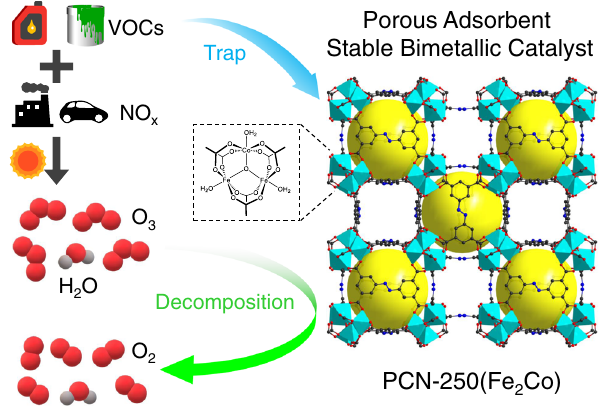
Fig. 1 | Schematic representation of the bimetallic MOF PCN-250(Fe 2 Co) as a porous catalyst for both O 3 and VOCs removal. The O, C, N atoms, MO 6 units (M=Fe or Co) and cages in PCN-250(Fe 2 Co) are represented by red, black, blue spheres, turquoise polyhedra, and large yellow spheres,